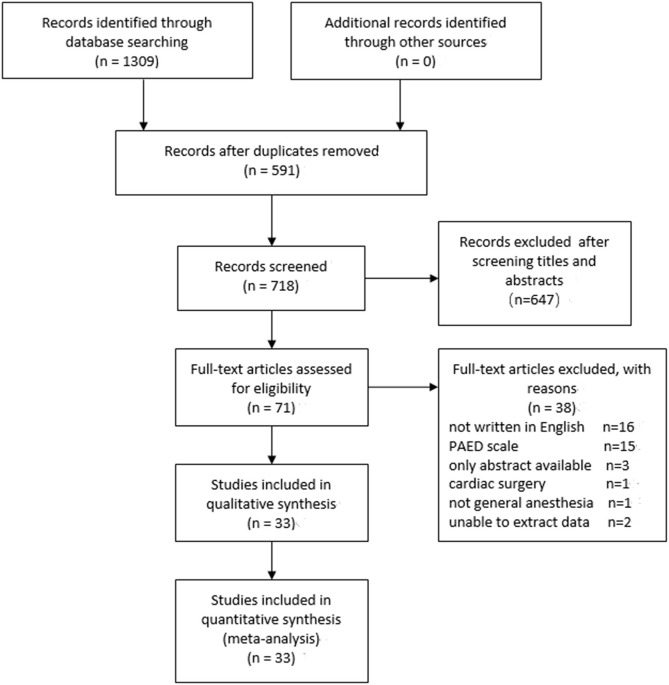
A PRISMA flow diagram of included/excluded studies.